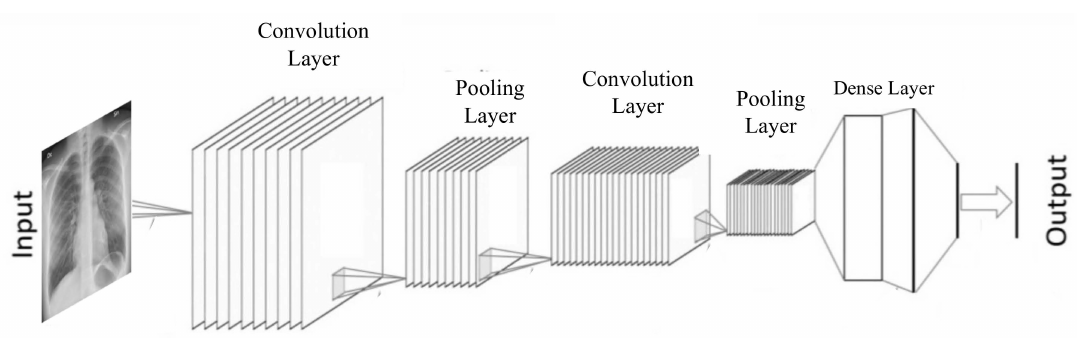
Figure 4. An illustration of Convolutional Neural Network with convolution and pooling layers for feature extraction and dense layer for classification.